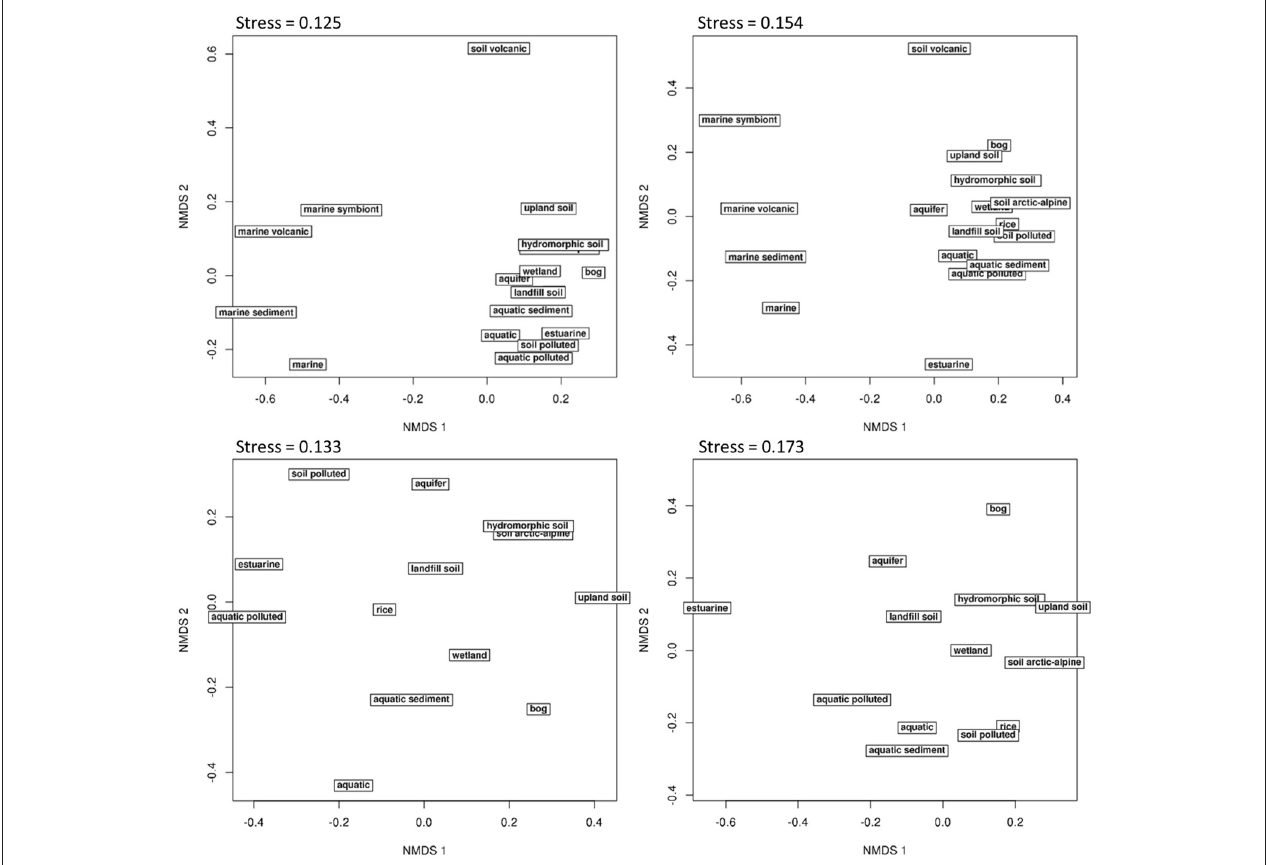
FIGURE 7 | Habitat specificity of methanotrophic bacteria evaluated in non-metric multidimensional scaling (NMDS) plots. Non-redundant sequence reads were used to calculate the relative detection frequency of all OTUs in a habitat. The upper plots show differences between all 18 different habitats, while the lower plots focus on the 13 most similar habitats. OTU clustering was done using 12% (left panels) and 4% dissimilarity cut-off (right panels). The NMDS plots were set up based on Bray-Curtis dissimilarities calculated from Hellinger transformed data using the online tool GUSTA ME ( Buttigieg and Ramette,